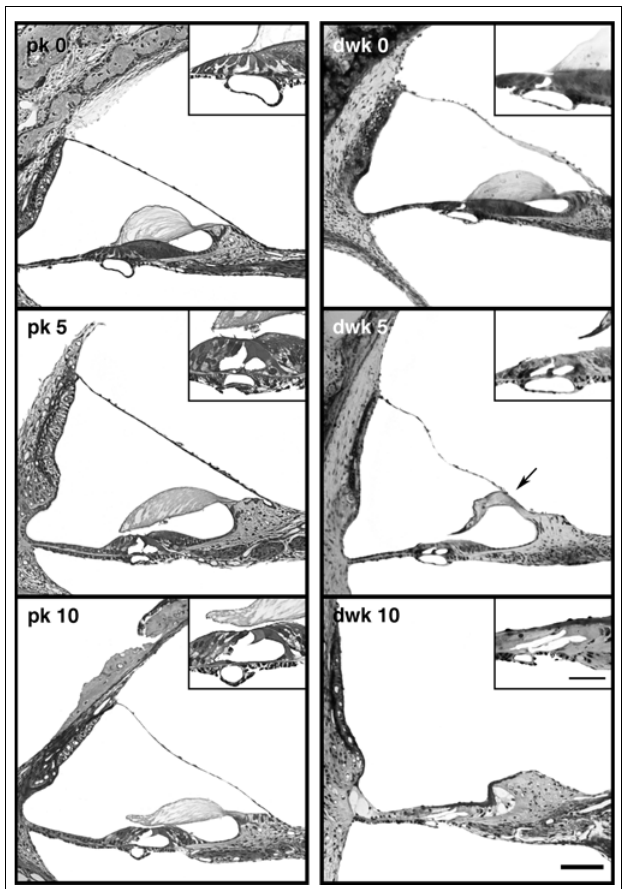
FIGURE 1 | Light micrographs of mid-modiolar cochlear sections from pigmented kittens (pk, left column) and deaf white kittens (dwk, right column). At day 0 (top row), the cochleae of white and pigmented kittens are similar in appearance. Reissner’s membrane and inner and outer hair cells (inset) are intact. At postnatal day 5 (middle row), the fi rst sign of cochlear degeneration is seen in white kittens as Reissner’s membrane begins its collapse onto the tectorial membrane (arrow). By postnatal day 10 (bottom row), Reissner’s membrane has fallen completely, obliterating the scala media and destroying the organ of Corti. Hair cells are no longer distinguishable in the damaged organ of Corti (inset). Scale bar equals 100 µm and 50 µm in the inset.